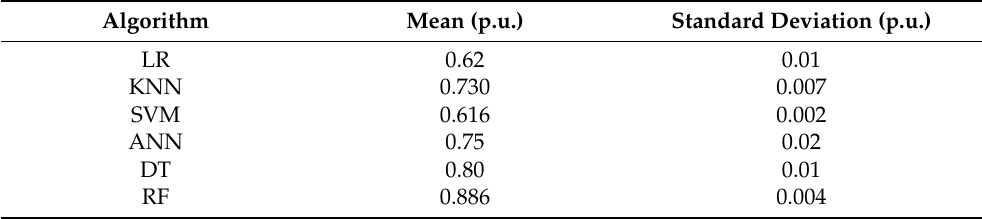
Table 3. Mean and standard deviation values of algorithms executed 500 times.